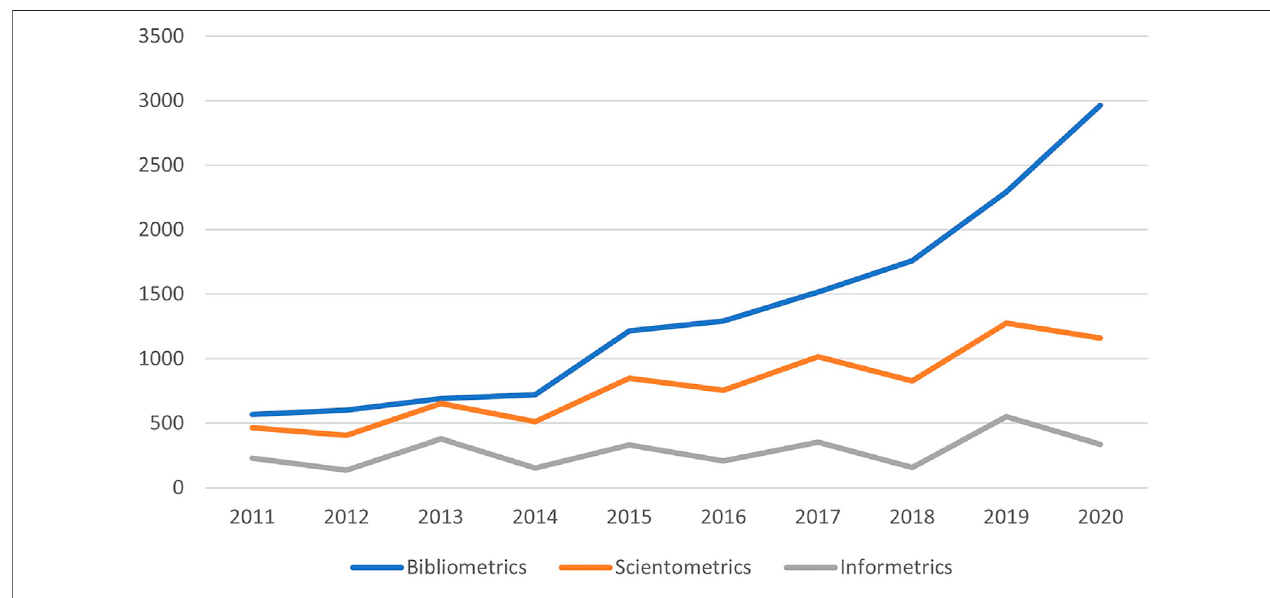
FIGURE 2 | Number of articles published per year.